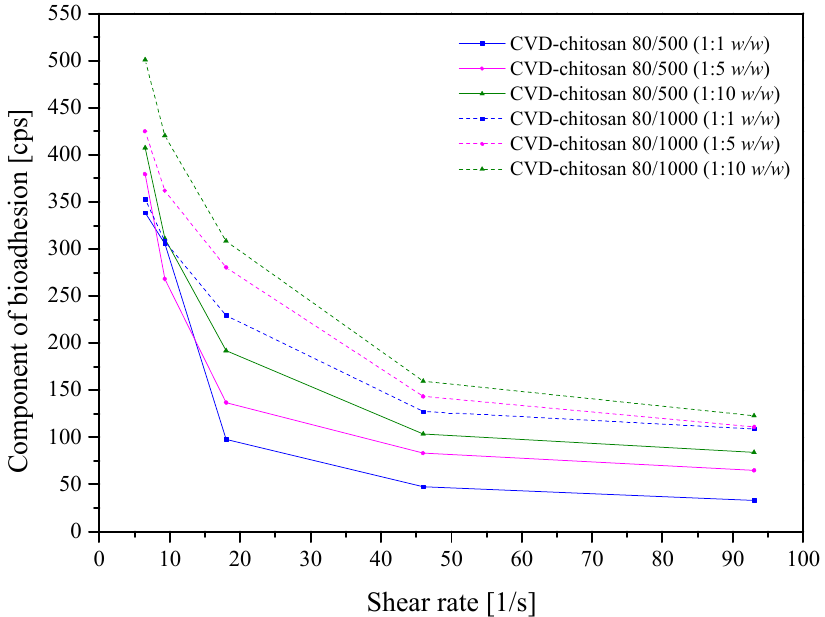
Figure 9. Effect of the shear rate on the component of bioadhesion of 1% CVD-chitosan systems.